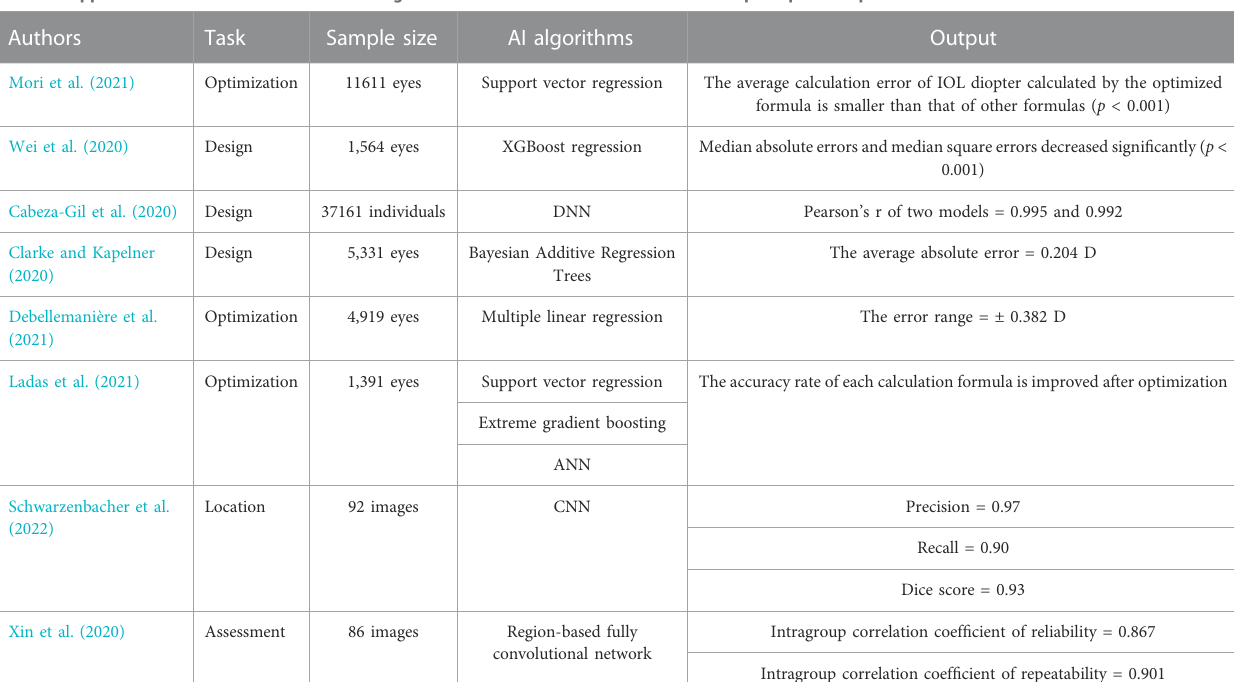
TABLE 4 Application of different AI models and algorithms in intraocular lens calculation and postoperative